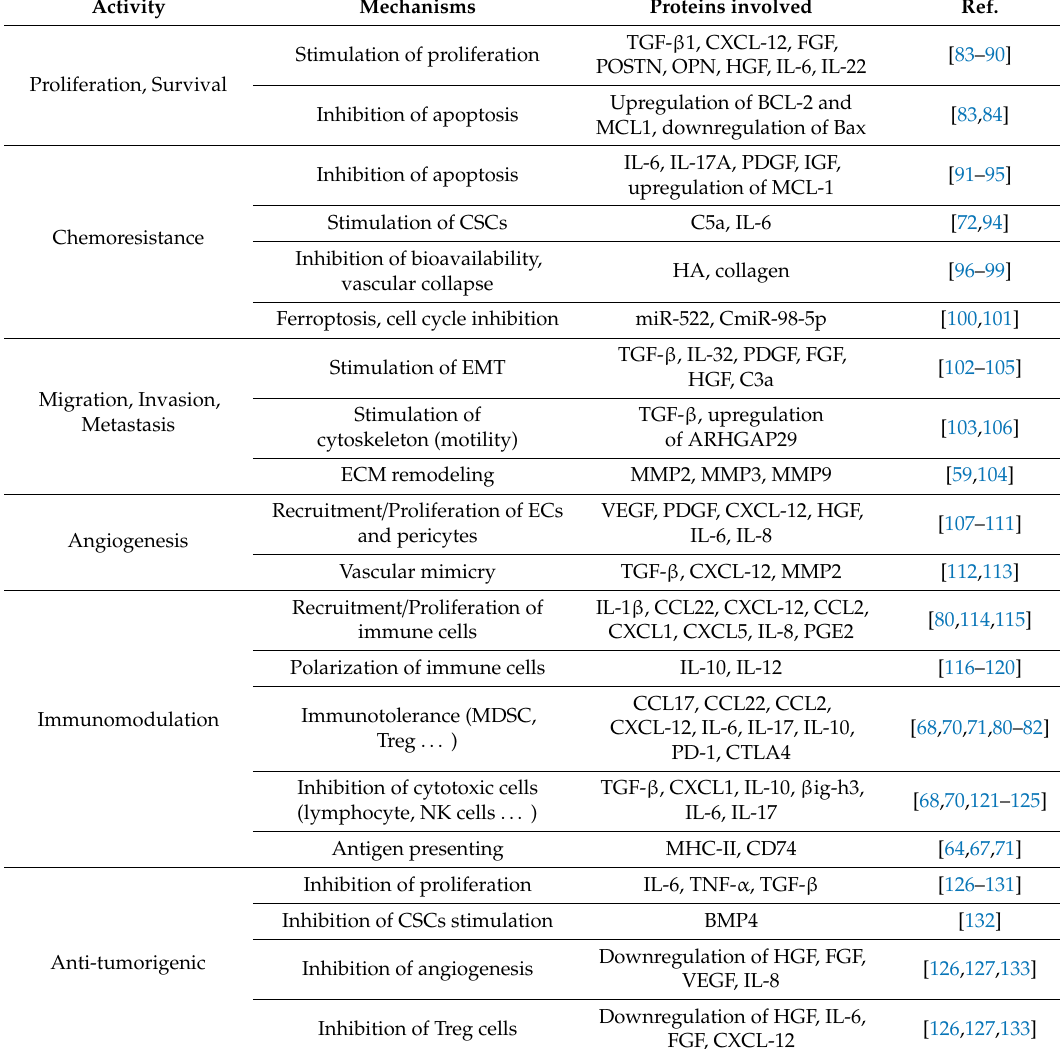
Table2. Di ff erentmechanismsofpro-and anti-tumorigenicCAFsactivitieswith